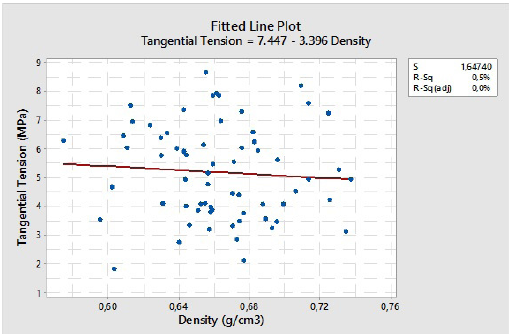
Figure 14. Plotting of the results for Tangential Tension Strength and Density.